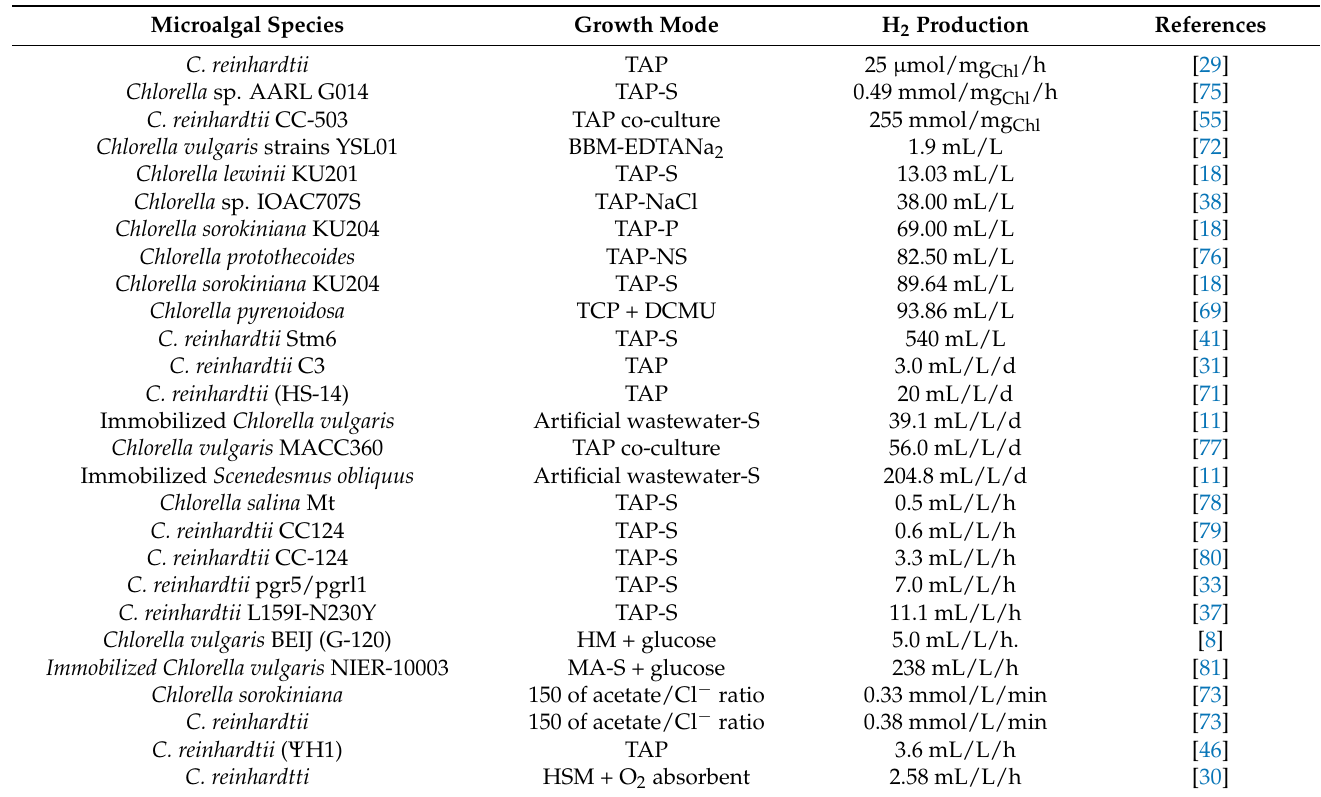
Table 1. Comparison of H 2 production rates in various microalgae